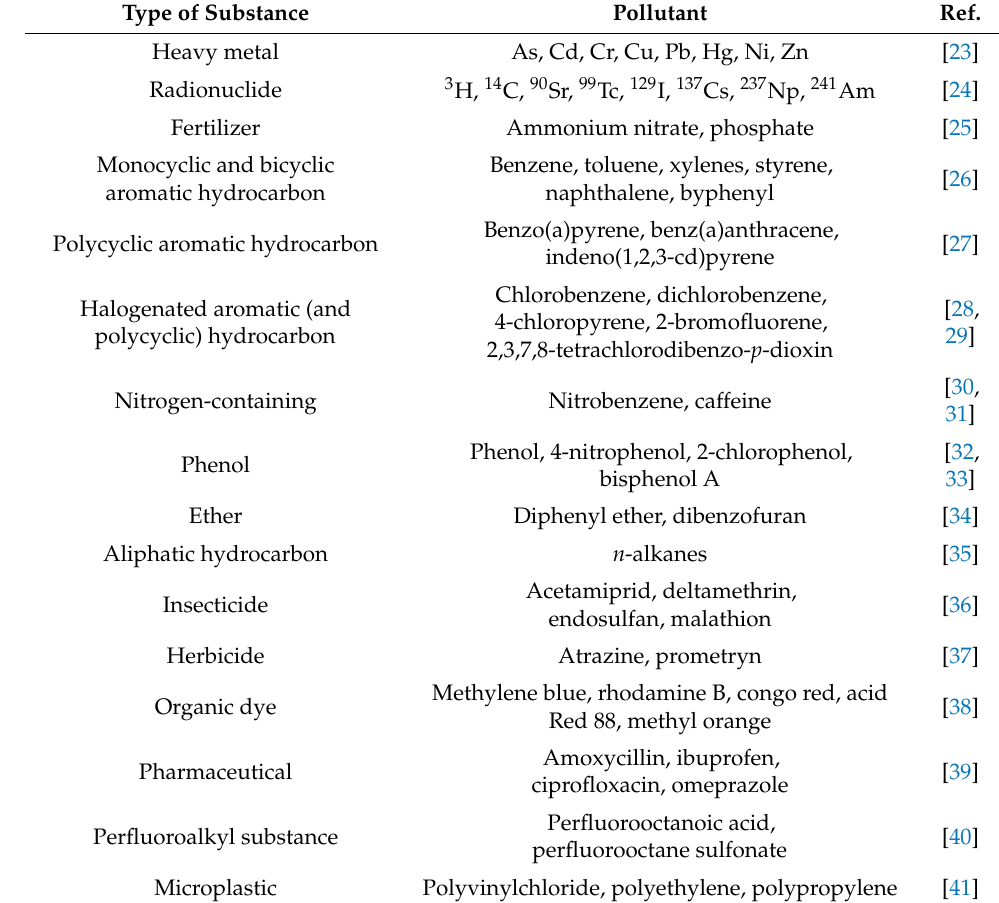
Table 1. List of some environmental hazardous substances. Type of